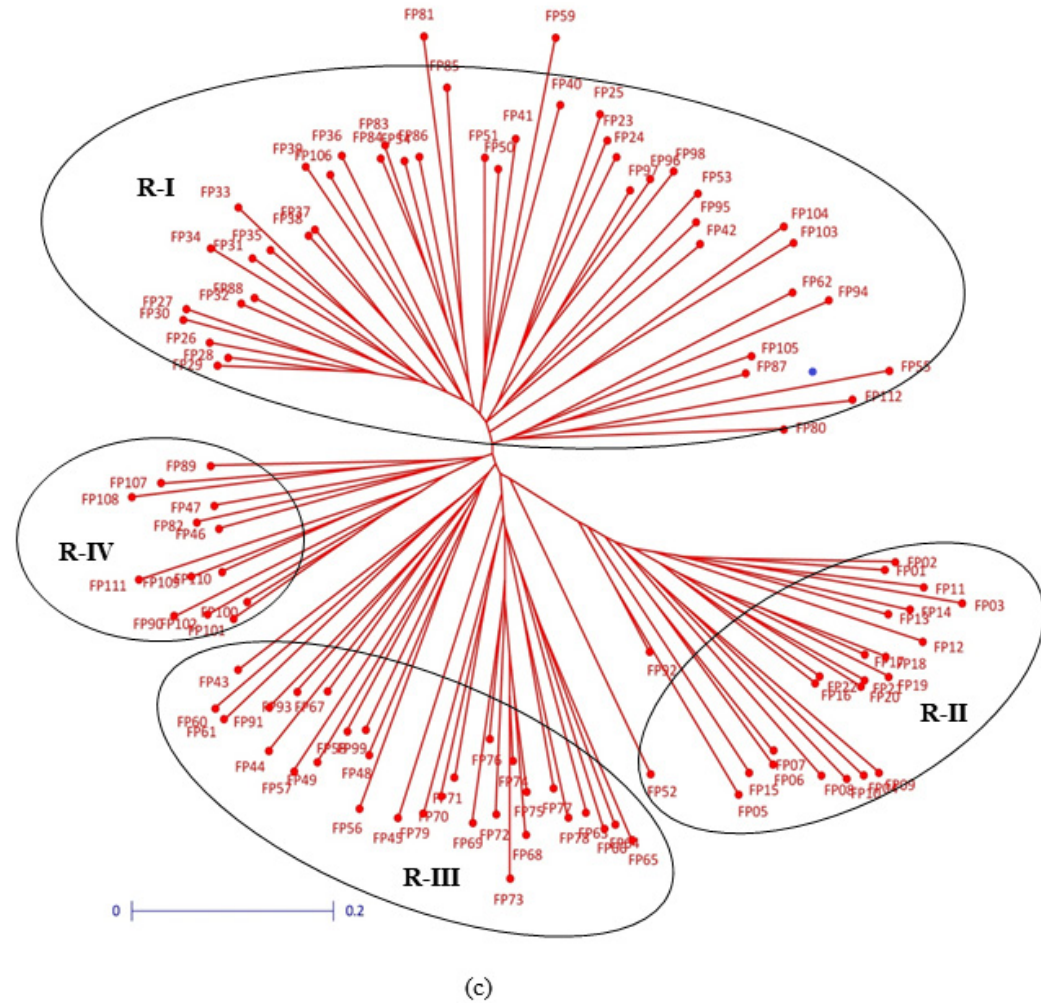
Figure 1. Neighbor joining tree based on 52 SSRs: ( a ) 130 seed and pollinator parents; ( b ) 18 seed parents; and ( c ) 112 pollinator parents.